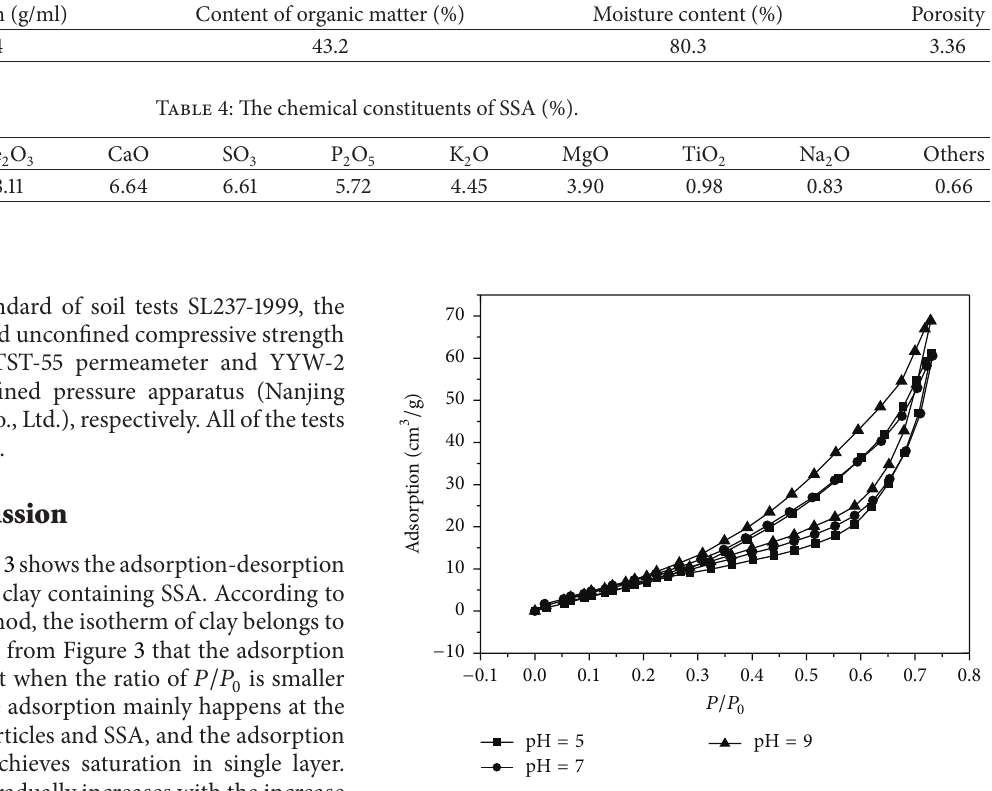
Figure 3: The adsorption-desorption isotherm of the modified clay containing